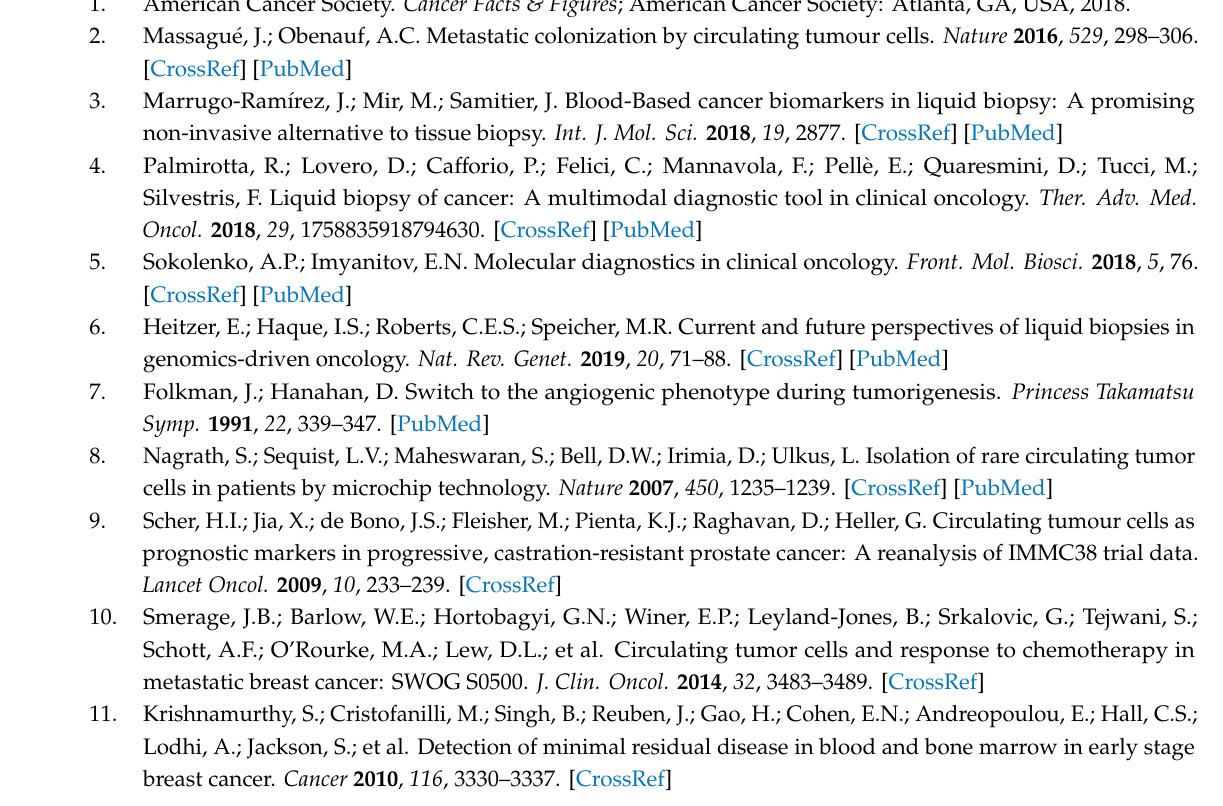
the expression data in each specimen analyzed. Table S2: Demographic and histopathological data of the breast samples evaluated. Table S3: List of blood samples analyzed. Table S4: Histopathological data of the matching samples evaluated. Table S5: List of genes selected and validated to NanoString